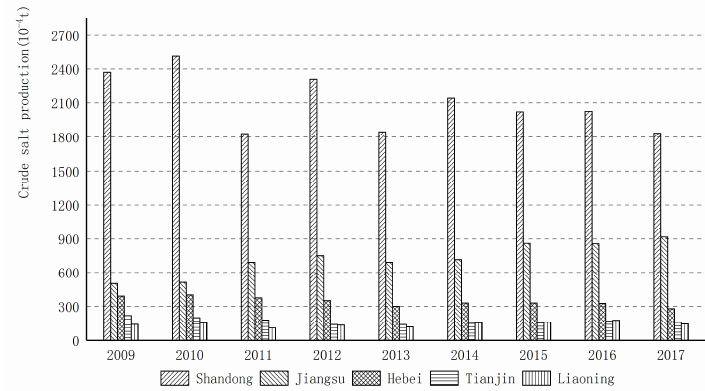
Figure 9. The crude salt production in the five largest areas during 2009–2017 in China. Data Source: National Bureau of Statistics of the People’s Republic of China, “Statistical Yearbook of China, 2009~2017” [22]. Table 2. The production (10 4 t) of NaOH and Na 2 CO 3 during 2009–2017 in China. 1.